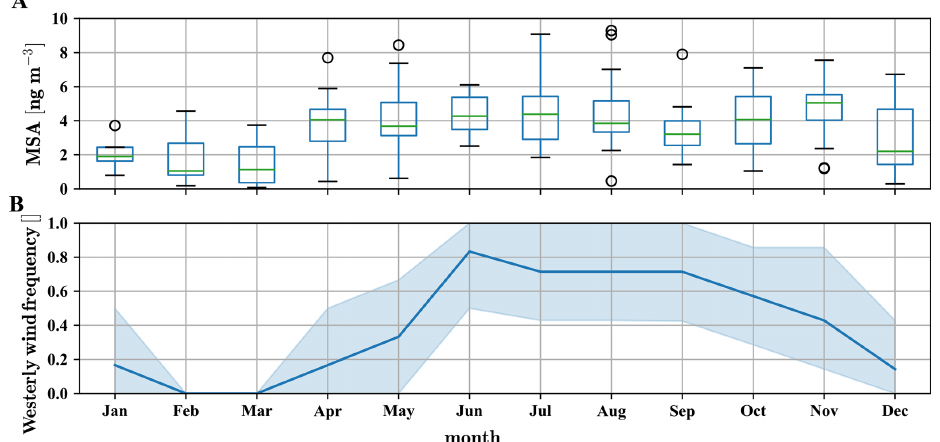
Figure 8. Yearly pattern of methanesulfonate mass concentration in PM 2 . 5 and PM 10 particles, based on data between 2012 and 2017, taken at CHC (a) and westerly wind (SSW to NW) frequency as measured on the Chacaltaya mountaintop (b) . In the months from December to March the wind is often coming from the east due to the Bolivian high (Bianchi et al., 2021). In these months methanesulfonate mass concentrations in the particles are significantly lower than during the rest of the